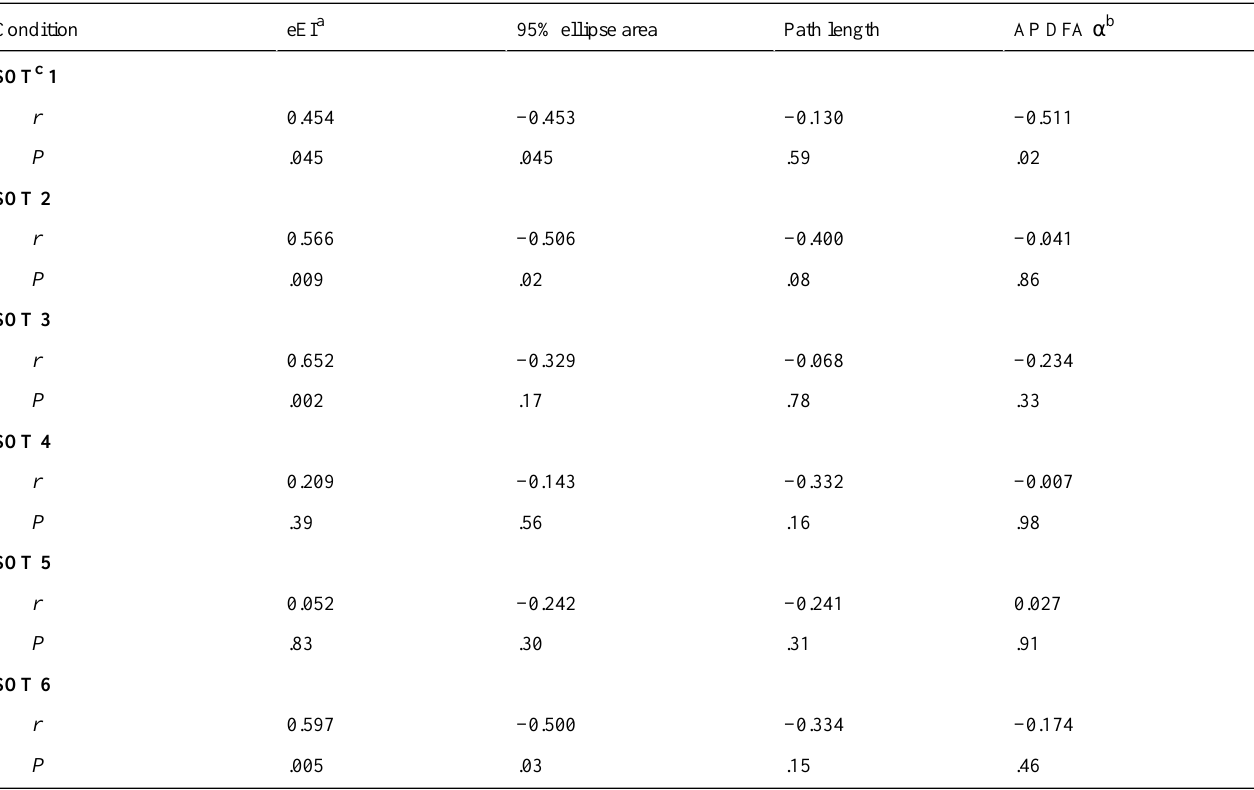
Table 3. Pearson correlation coefficients between force plate measurements (columns) and the equilibrium index during each sensory organization test